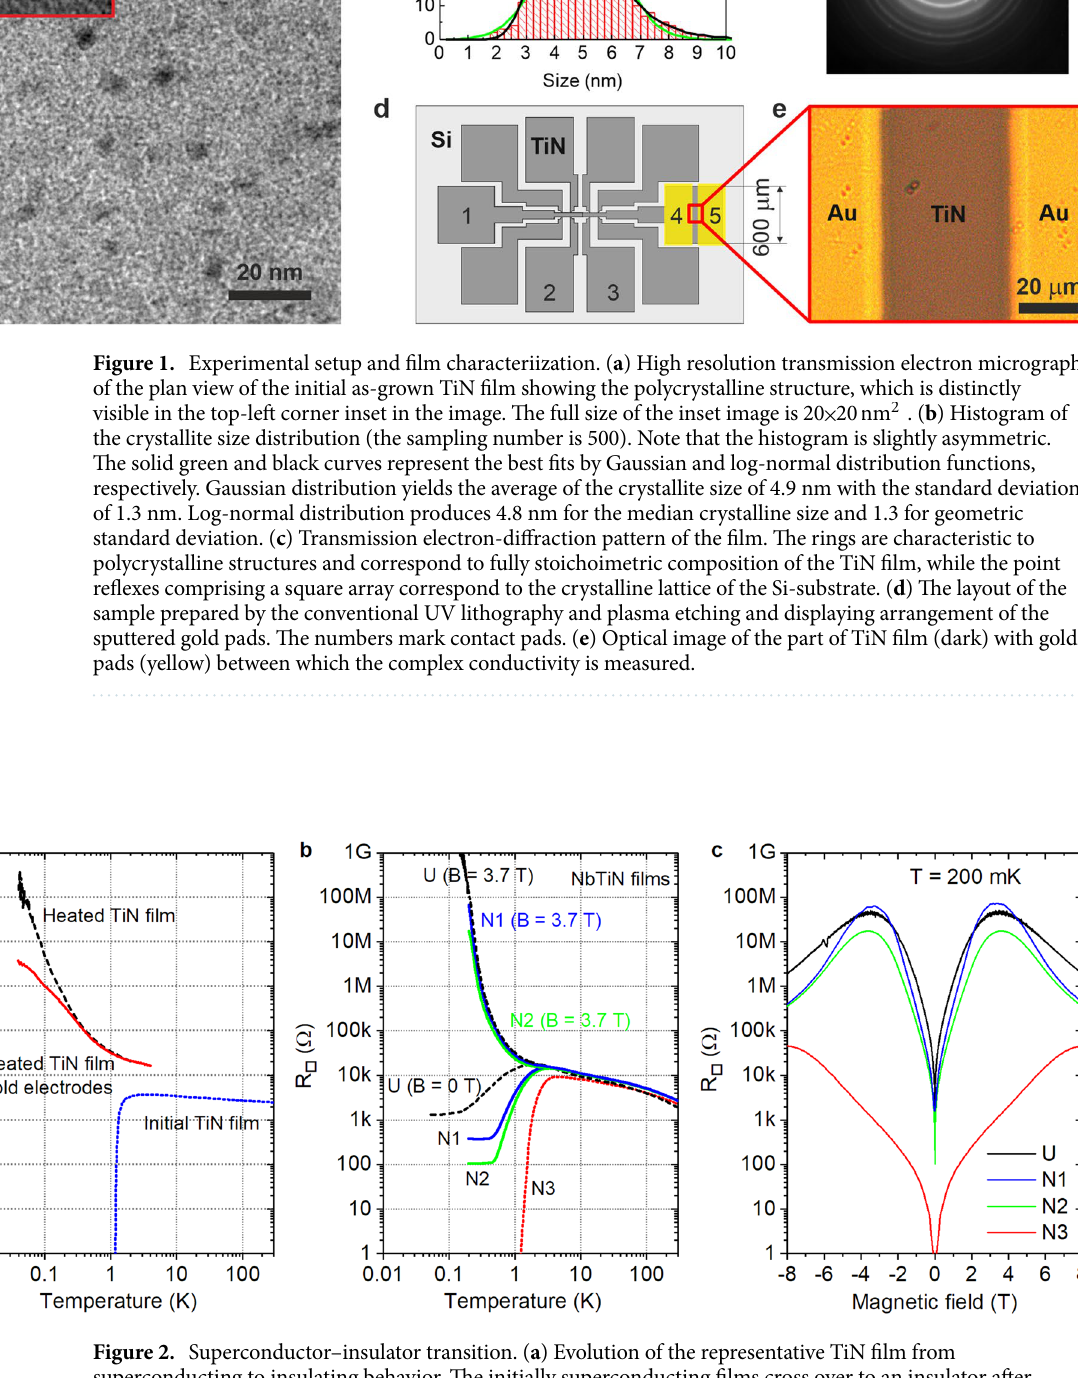
Figure 2. Superconductor–insulator transition. ( a ) Evolution of the representative TiN film from superconducting to insulating behavior. The initially superconducting films cross over to an insulator after heating to 600 K. After thermal evaporation of gold electrodes and decreasing distance between contacts from 2.5 mm to 50 µ m, the insulating upturn slightly flattens. ( b ) The SIT in the NbTiN films. The changes of thickness (samples N1, N2, N3) and stoichiometry (samples UofC and N1) lead to changes of critical temperatures. The films are driven across the SIT by varying magnetic field. Note that superconducting samples saturate to metallic behavior at the lowest temperatures that correspond Bose-metallic behaviour 17 . ( c ) The magnetic field-induced SIT in NbTiN films for different samples at temperature of 200